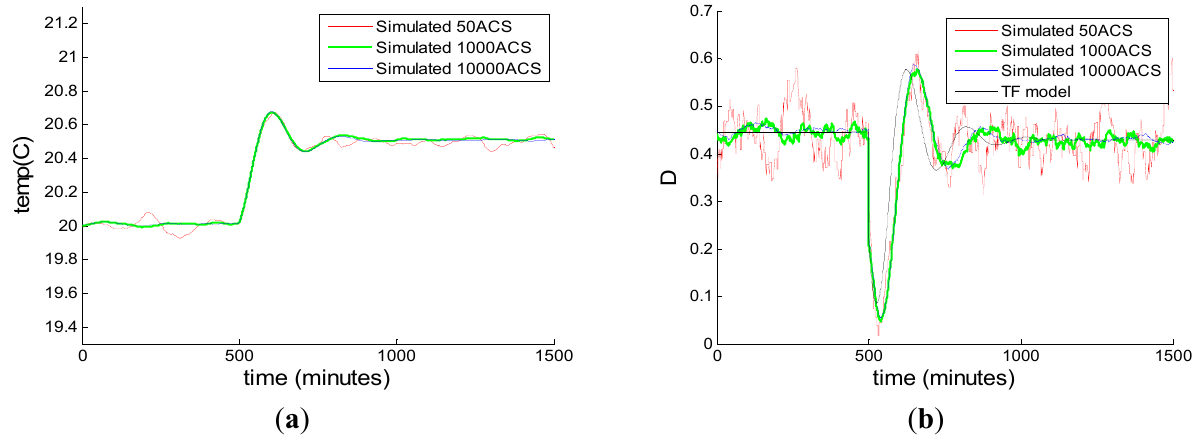
Figure 8. ( a ) The variation on the average temperature inside the room and ( b ) the variation on the aggregated demand of the AC group when the ACs’ temperature set point has a step rise of 0.5 °C. The two order linear time invariant transfer function model is compared with the ETP model which contains 50, 1000 and 10,000